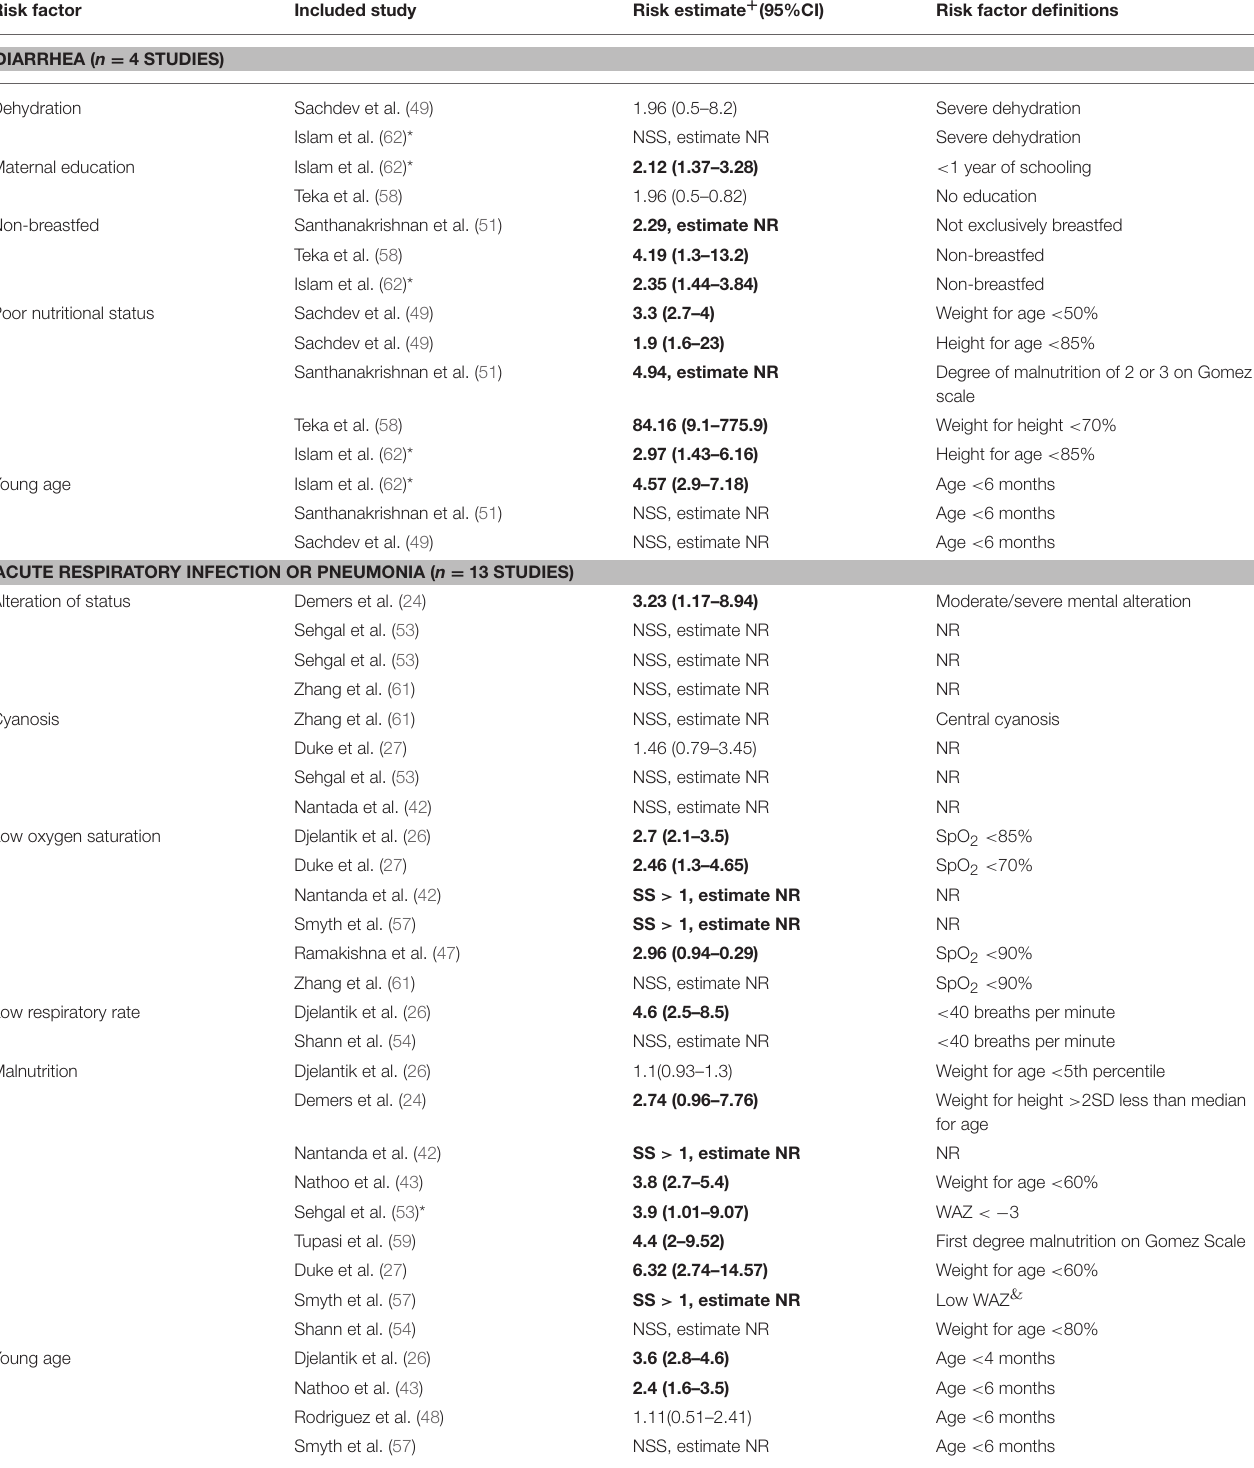
TABLE 4 | Summary of risk factors for infant mortality by underlying